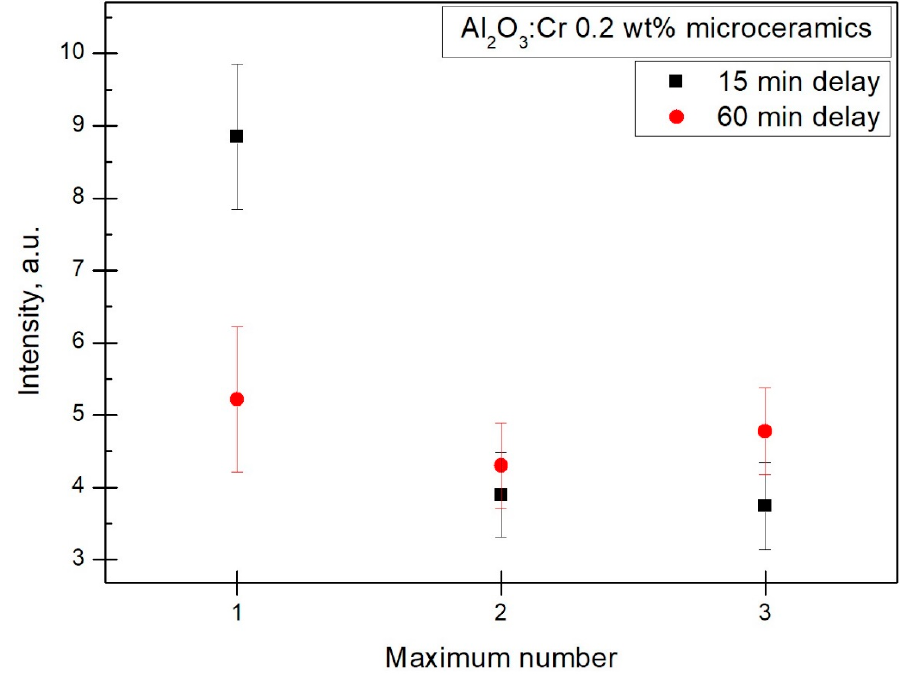
Figure 9. TL peak intensity variance caused by increased delay time in Al (cid:2870) O (cid:2871) :Cr with 0.2 wt% Cr (cid:2870) O (cid:2871) .